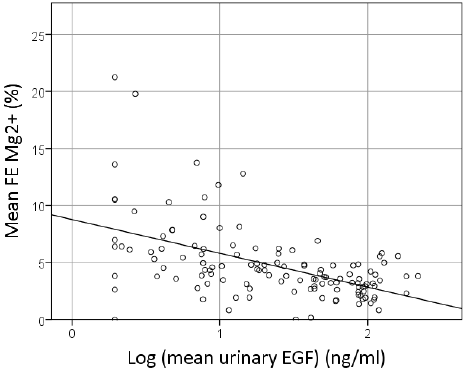
Figure 2. Correlation between the EGF and fractional excretion (FE) of magnesium. Logarithmic normalized data of the EGF are presented.